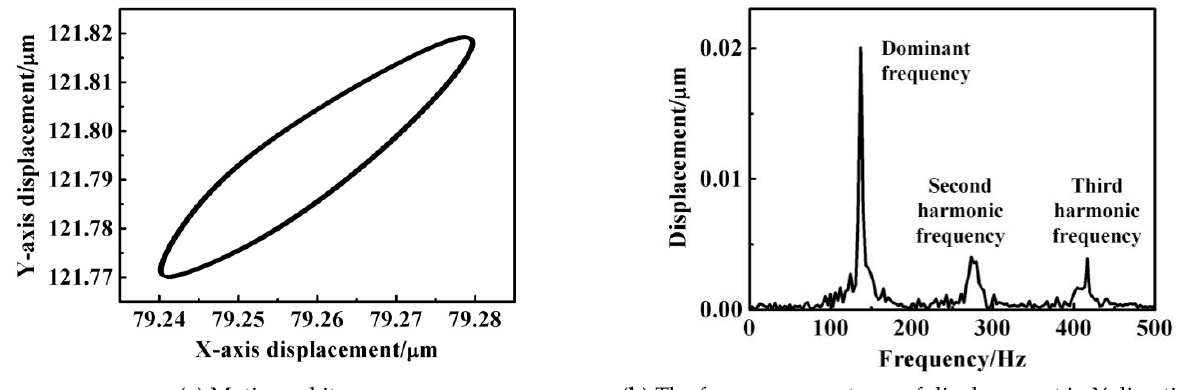
Figure 13. Dynamic characteristics of the inner ring.